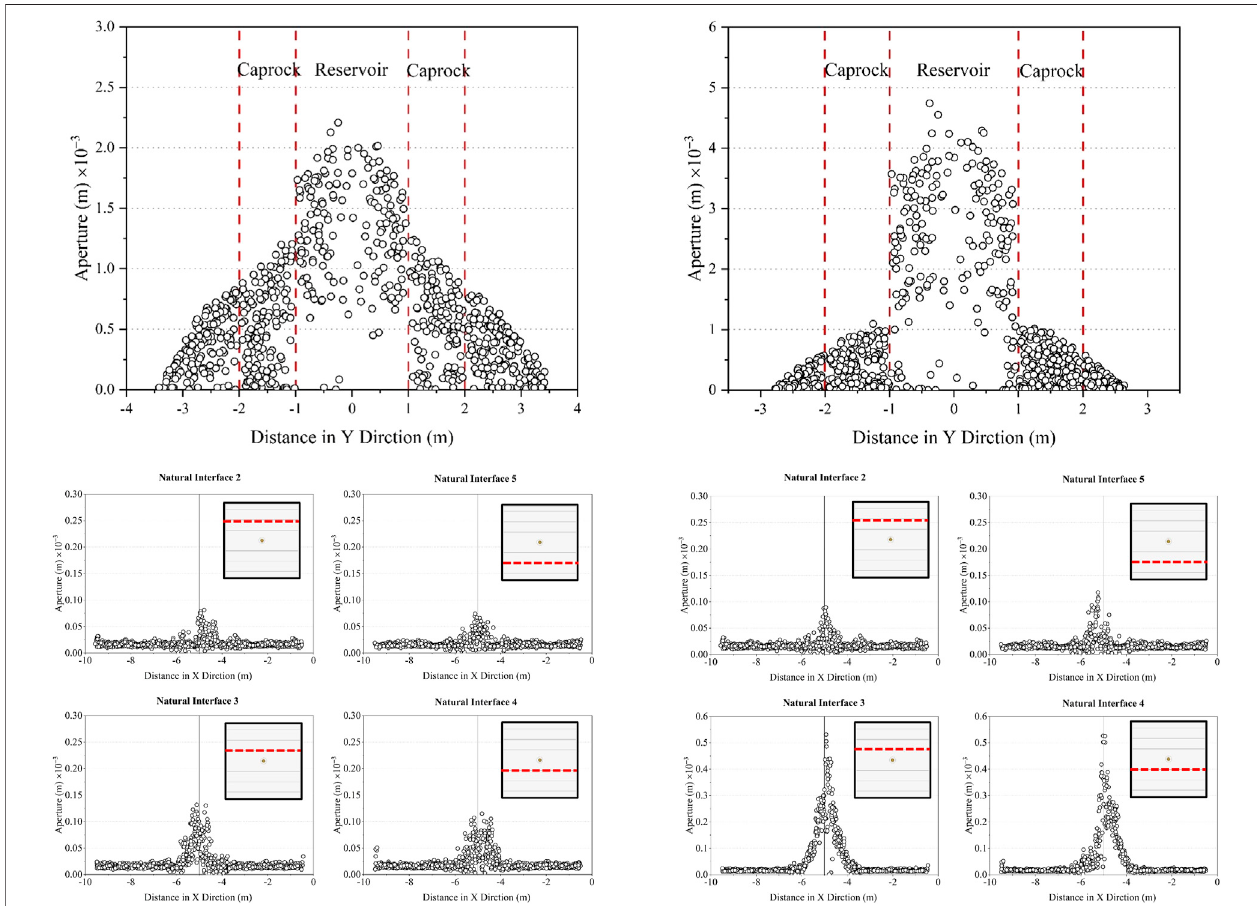
FIGURE 12 | Pro fi les of the HF aperture in the YZ plane at X (cid:2) − 5 m for injection rates of (A) 0.02 m 3 /s and (B) 0.1 m 3 /s. The wellbore injection point is at Y (cid:2) 0 m. Andpro fi lesofthenaturalinterfaceapertureintheXZplaneatZ (cid:2) 4 mforinjectionratesof (C) 0.02 m 3 /sand (D) 0.1 m 3 /s.HFinthisplaneisatX (cid:2) − 5 m.Thediagramin the upper right shows the position of the corresponding natural fracture in the